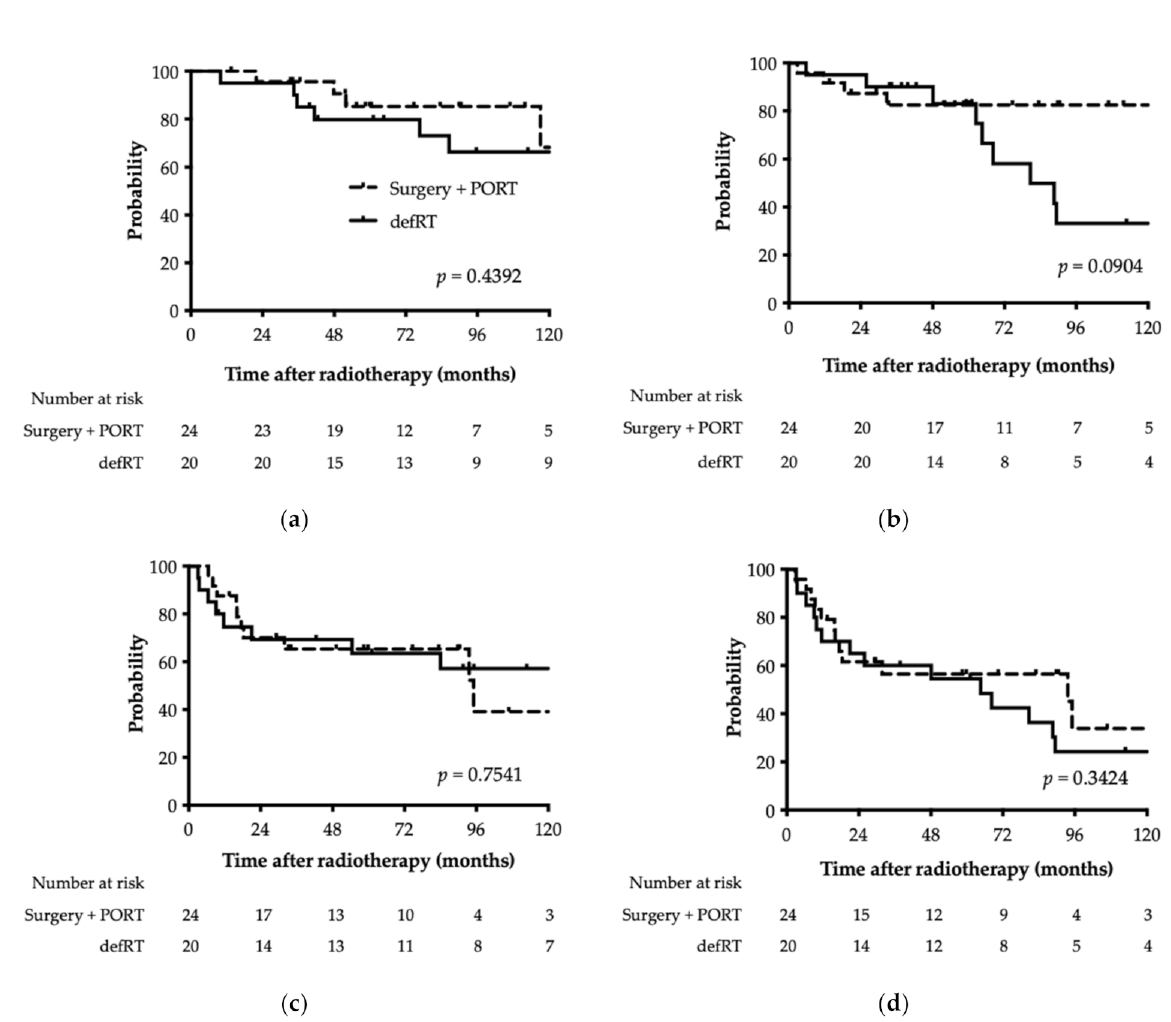
Figure 2. Kaplan–Meier plot of ( a ) overall survival, ( b ) local control, ( c ) distant metastasis, and ( d ) progression-free survival rate. The solid line indicates definitive radiotherapy, and the dashed line indicates surgical resection followed by postoperative radiotherapy. PORT, postoperative radiotherapy; defRT, definitive